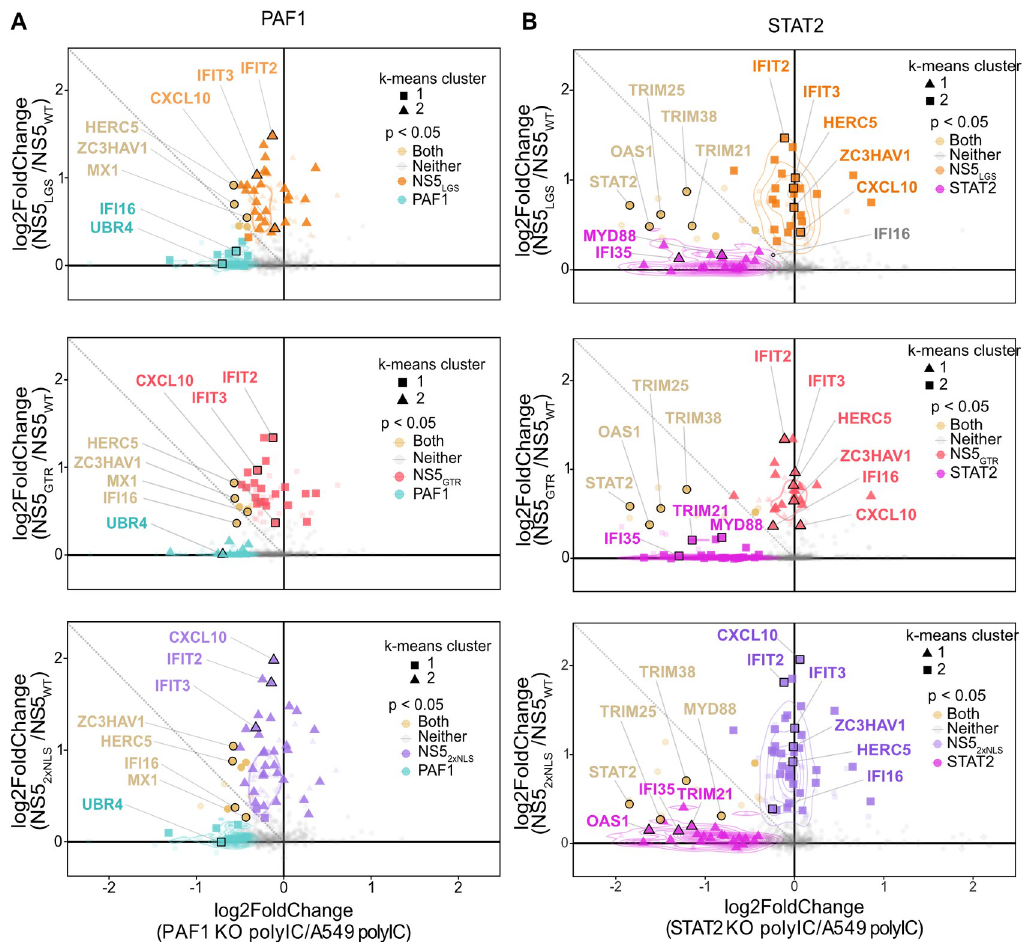
Fig 7. NS5 mutants rescue expression of PAF1-dependent genes. Relative gene expression was plotted as log2 fold change for (A) PAF1 KO versus parental A549 cells or (B) STAT2 KO versus parental A549 (same as Fig 2E), and NS5 mutant versus WT. Unsupervised K-means clustering was also performed to identify genes with similar behavior (triangles, circles and squares). P values were adjusted for false discovery rate using the Benjamini Hochberg method. Significant changes in gene expression are plotted for: PAF1 KO (cyan), both (yellow), neither (grey), NS5 LGS (orange), NS5 GTR (red) and NS5 2xNLS (purple). Immune response genes (GO:0006955) are highlight with larger markers and opaque coloring.